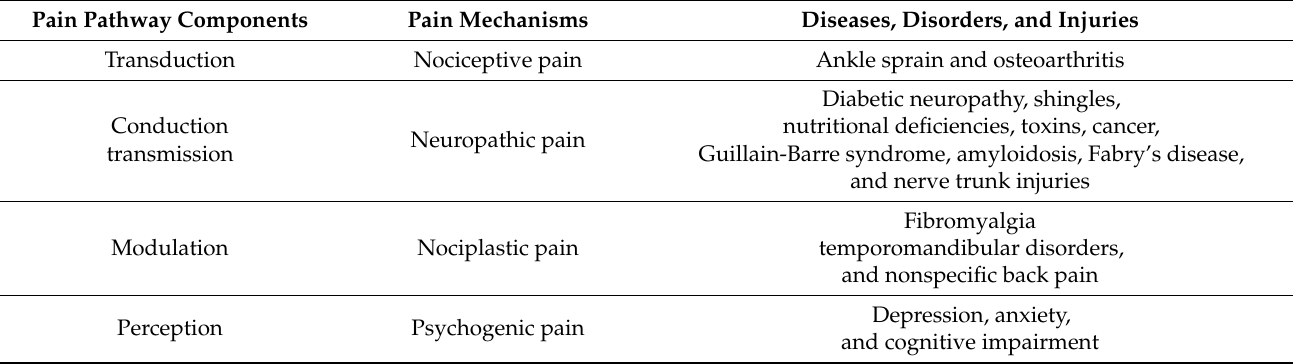
Table 1. Pain pathway components, pain mechanisms, and representative diseases. Pain Pathway